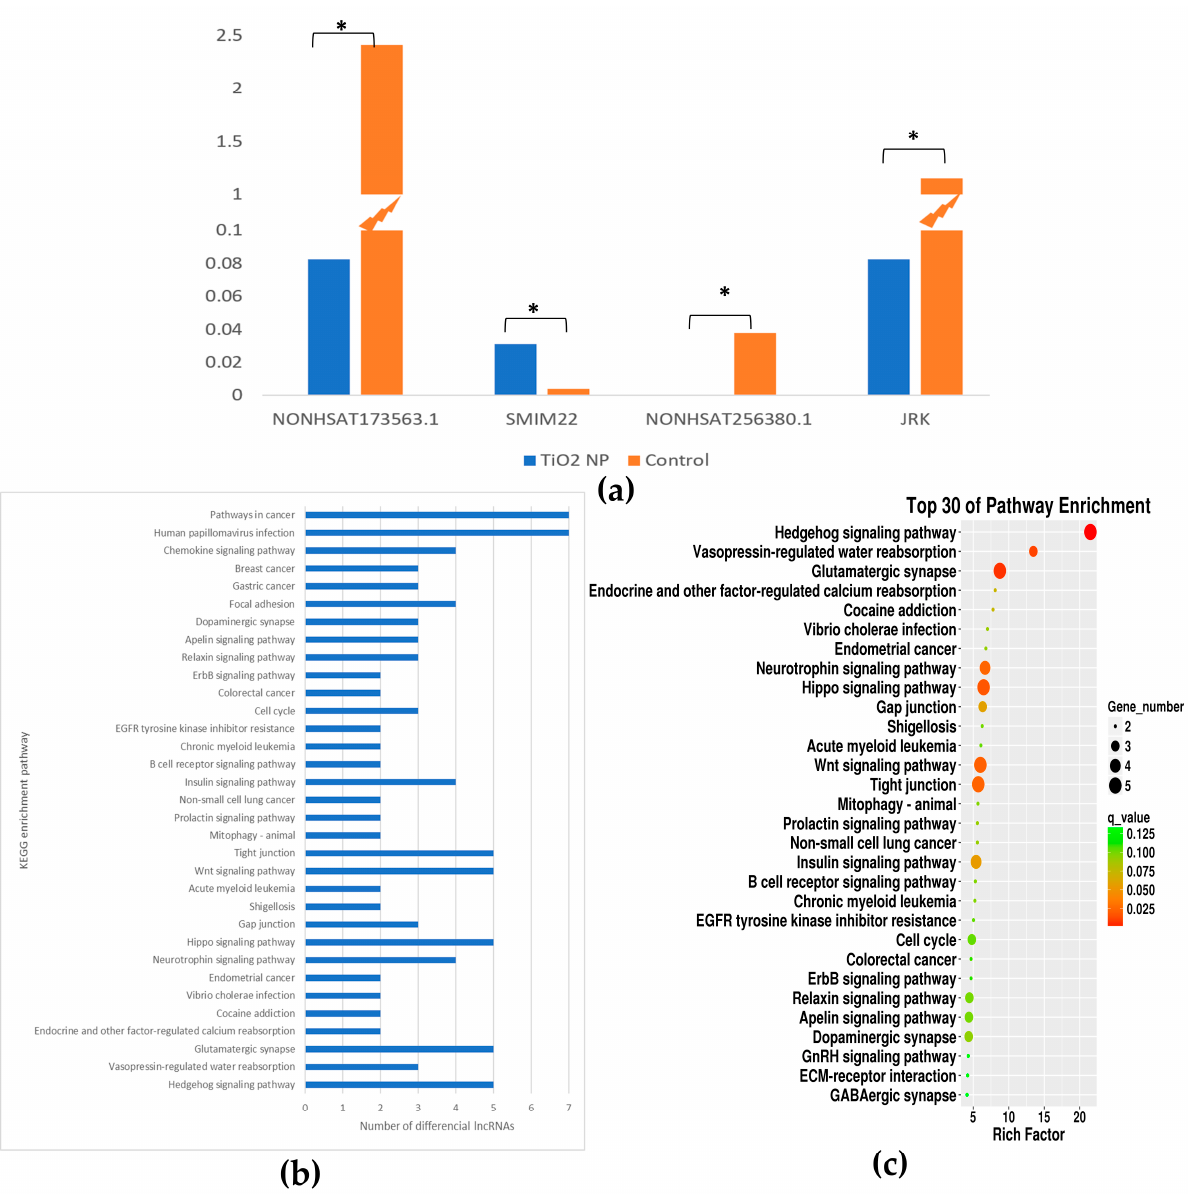
Figure 6. Pathway analysis of TiO 2 NPs with concentrations of 0 and 100 μ g/mL. A bar graph of differential lncRNAs numbers in different pathways of KEGG was drawn ( a ). A KEGG enrichment analysis bubble plot was drawn in the descending order of q value corresponding to each entry in the TiO 2 NP treatment group ( b ). The relative content of the two lncRNAs and corresponding mRNAs in the TiO 2 NP treatment and the control group was drawn in a histogram (* p < 0.05) ( c ).